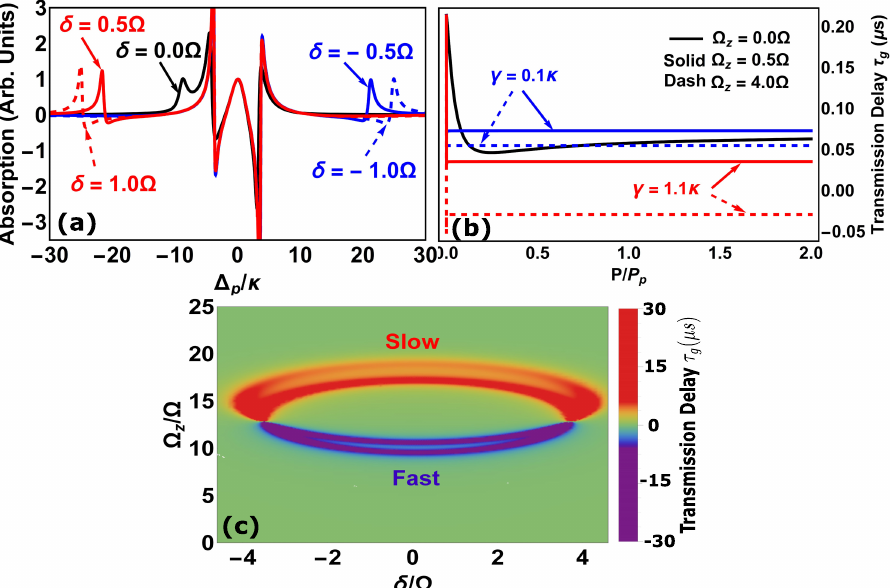
Fig. 4 In fl uence of Raman process on EIT spectrum as well as fast and slow light. a The absorption spectrum Re [ ε out ] versus Δ p / κ under in fl uence of δ / Ω . b The transmission delay τ g versus P / P p under in fl uence of Ω z / Ω in lossy κ / γ > 1 and gain κ / γ < 1 regime. c The slow and fast dynamics of probe light (with τ g ) as a function of Ω z / Ω and δ / Ω when P = 1.5 P p . α = 2 Ω in these